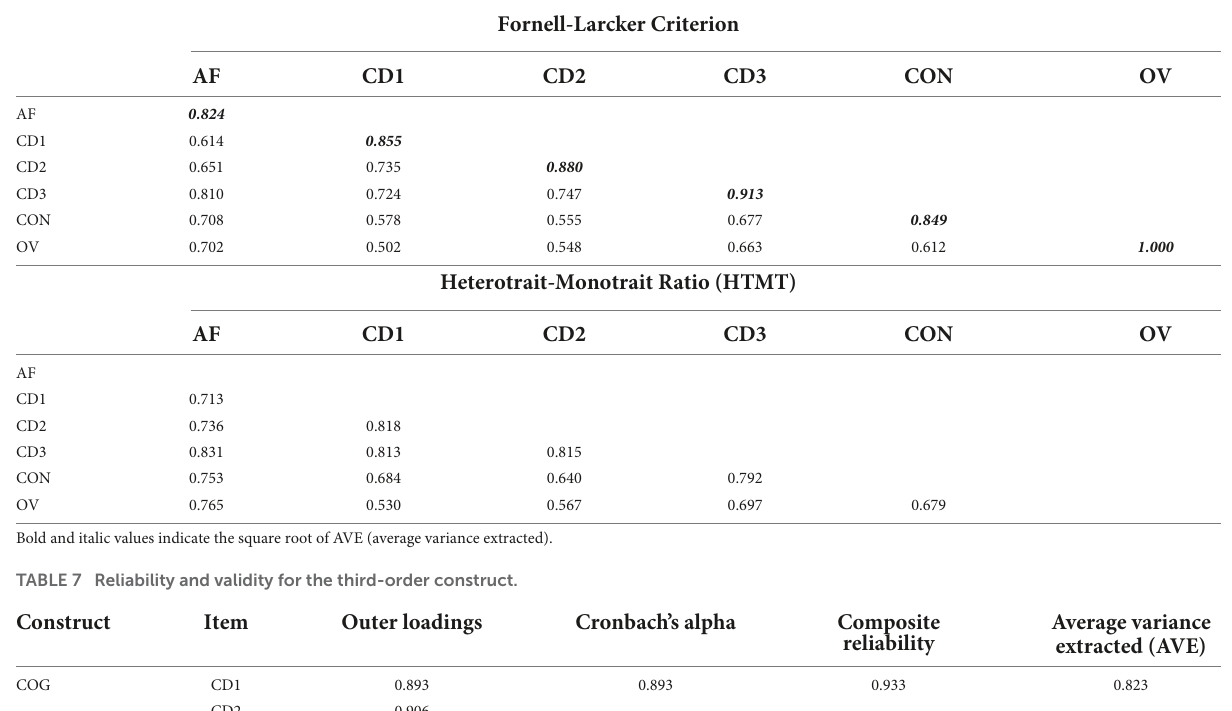
TABLE 6 Discriminate validity for second-order constructs.